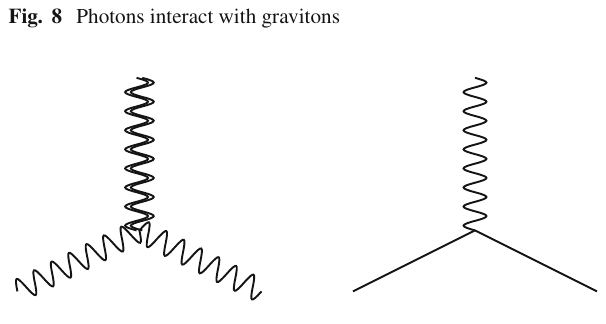
Fig. 9 Two vertices which contain photons